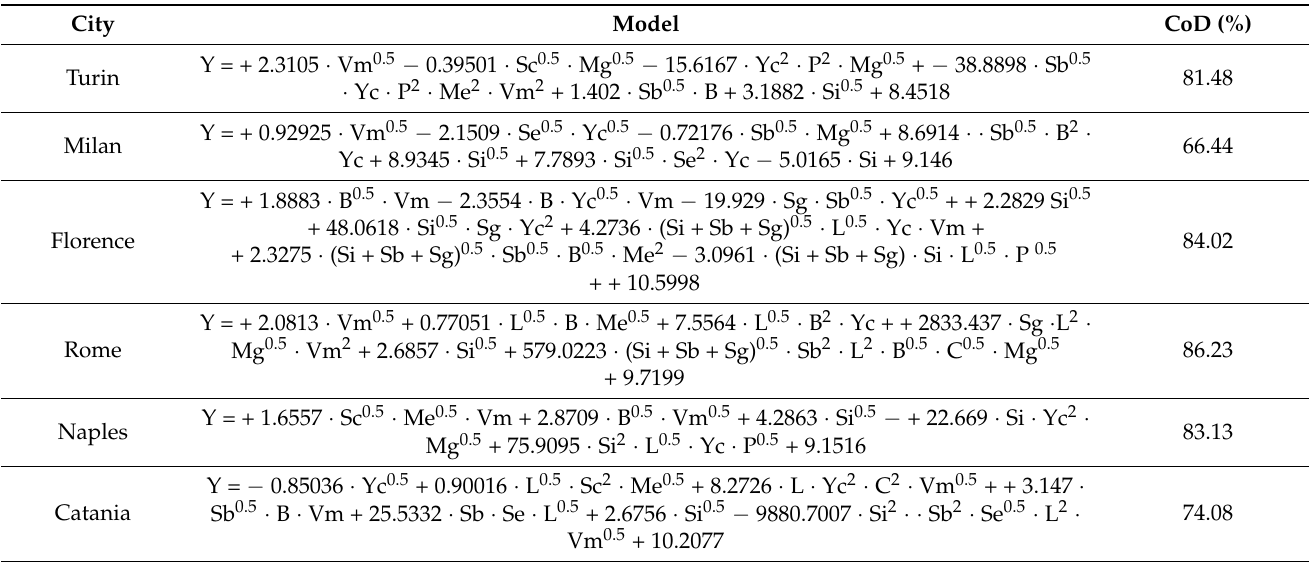
Table 3. Models chosen from the EPR-MOGA implementation outputs for each Italian city analyzed. City